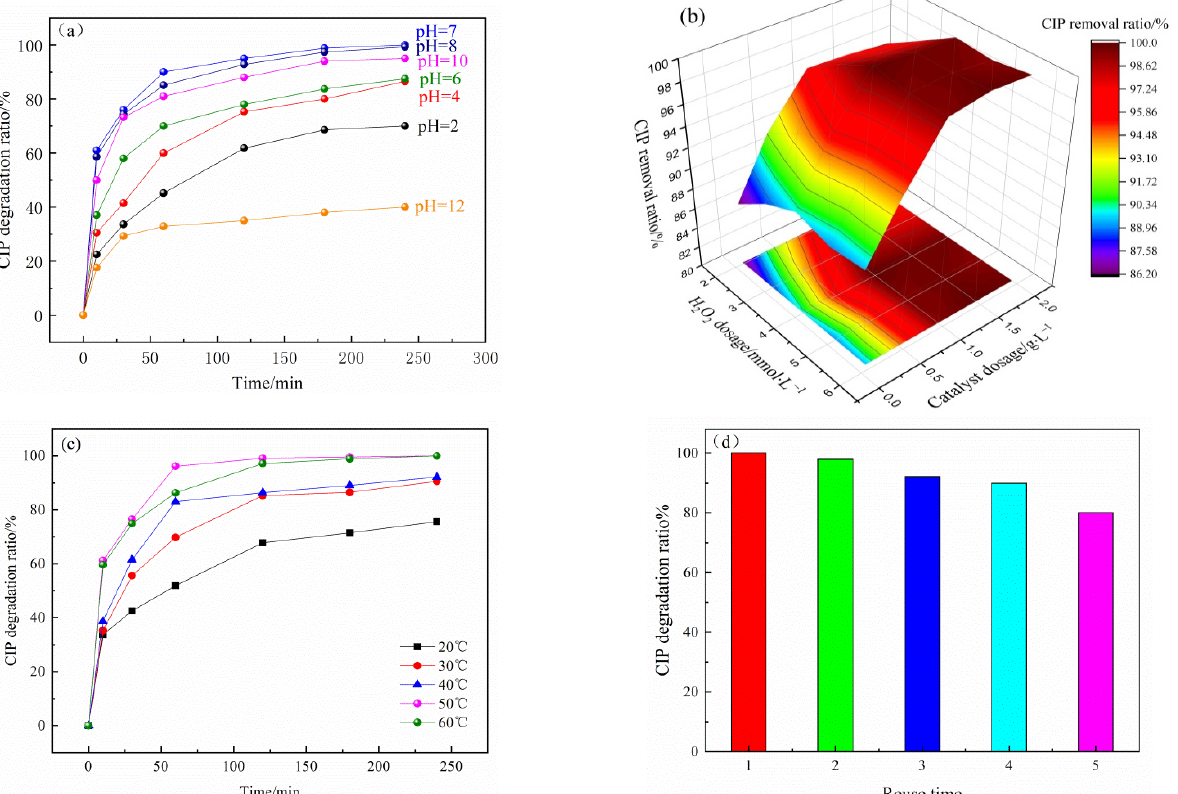
Figure 4. Effects of pH value ( a ), catalyst dosage and H 2 O 2 concentration ( b ); temperature ( c ) on the degradation of CIP by CuO/GO-DE catalyst; the reusability of CuO/GO-DE catalyst ( d